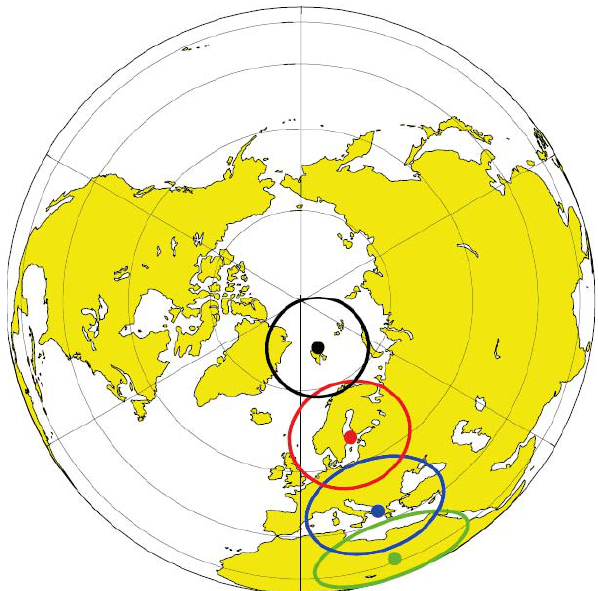
Fig. A3. Example of search circles used for sign tests, spatial av- eraging and gridding placed along 20 ◦ E. Their radii decrease lin- early with latitude from 2000km at the equator to 1000km at the pole. The four circles illustrated are placed at 20 ◦ , 40 ◦ , 60 ◦ and 80 ◦ N and have radial distances of 1778km, 1556km, 1333km and 1111km, respectively. The apparently elliptic shape of the circles is a consequence of the map projection.